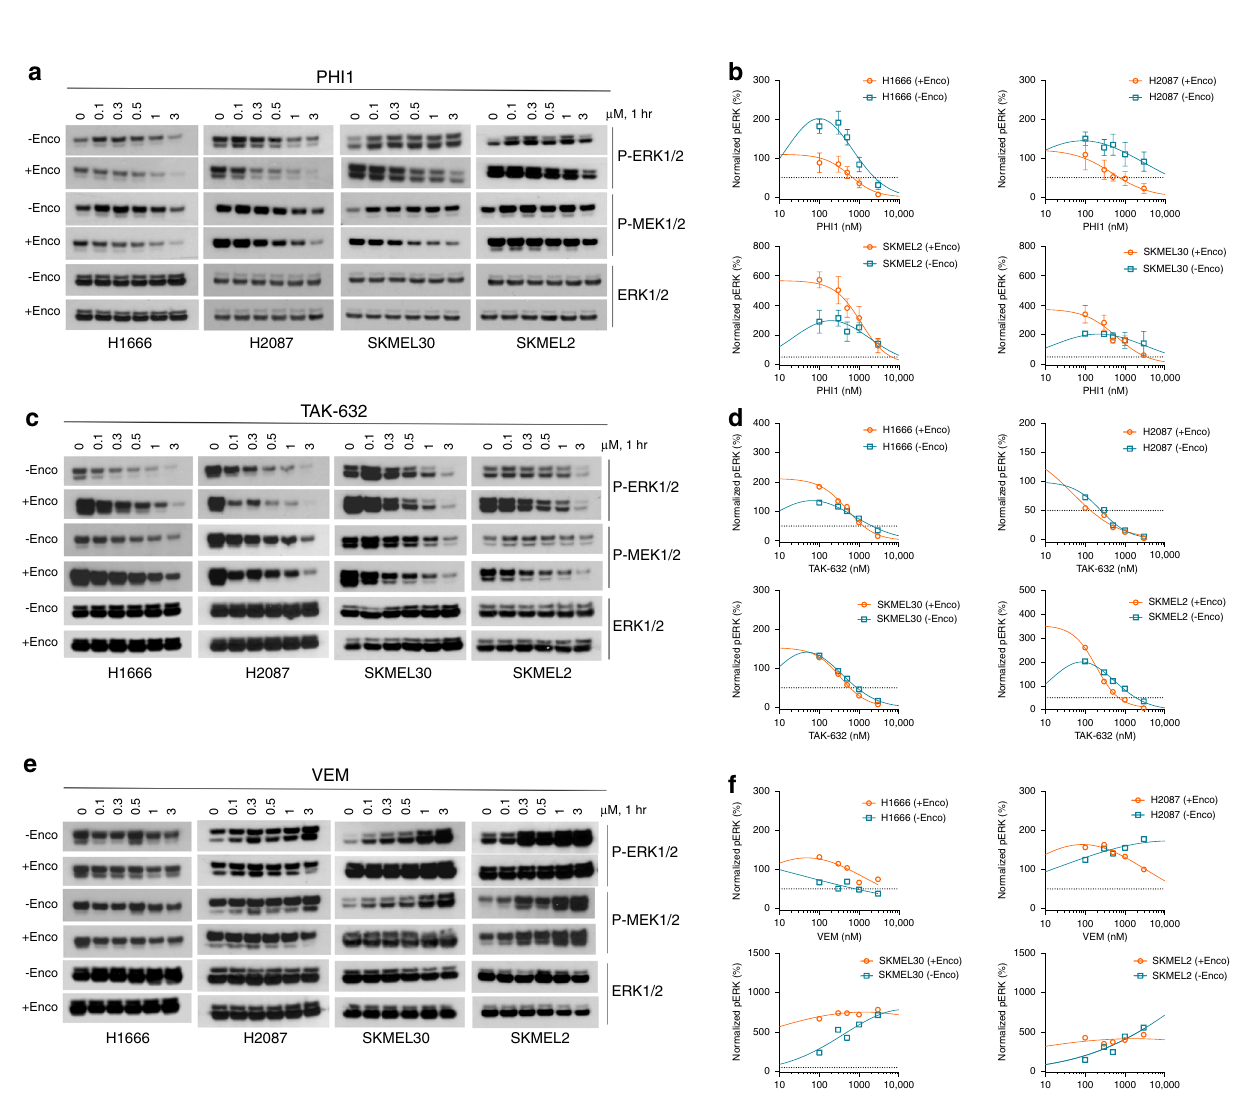
Fig. 7 Positive co-operativity in inhibition of non-BRAFV600E dimers by PHI1. Lung cancer H1666 ( BRAF G 466V ), H2087 (BRAF L597V ), and melanoma SKMEL-30 (BRAF WT /NRAS Q61R ), SKMEL-2 (BRAF WT /NRAS Q61K ) cells without Encorafenib ( − Enco) treatment and after Encorafenib ( + Enco) treatment for 1 h, followed by exchange with fresh medium for another hour, were treated with increasing concentrations of a PHI1, c TAK-632, and d Vemurafenib for 1 h and cell lysates were assayed by western blot with the indicated antibodies to assess the ERK-pathway inhibition. A representative blot from n = 3 ( a , b ) and n = 2 ( c , e ) independent experiments is shown. Normalized values and non-linear regression fi ts of p-ERK activity for each treatment is shown in b , d , and f , respectively. Error bars represent mean ± SEM, n = 3 ( b ) and mean of two replicates from n = 2 independent experiments ( d , f ). Notably, Encorafenib pre-treatment promotes paradoxical activation in these cells. Source data are provided as a Source Data fi